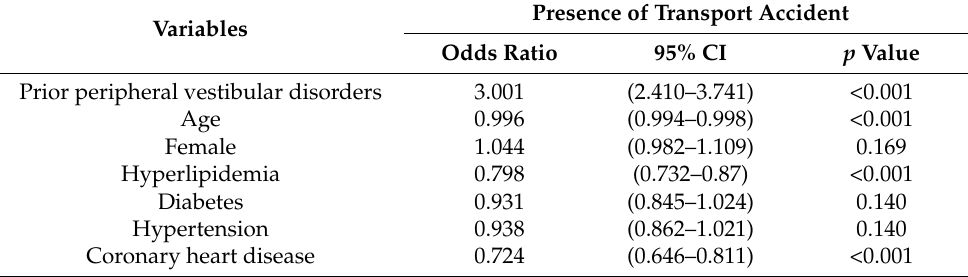
Table 3. Covariate-adjusted odds of prior peripheral vestibular disorders among the sampled patients ( n =